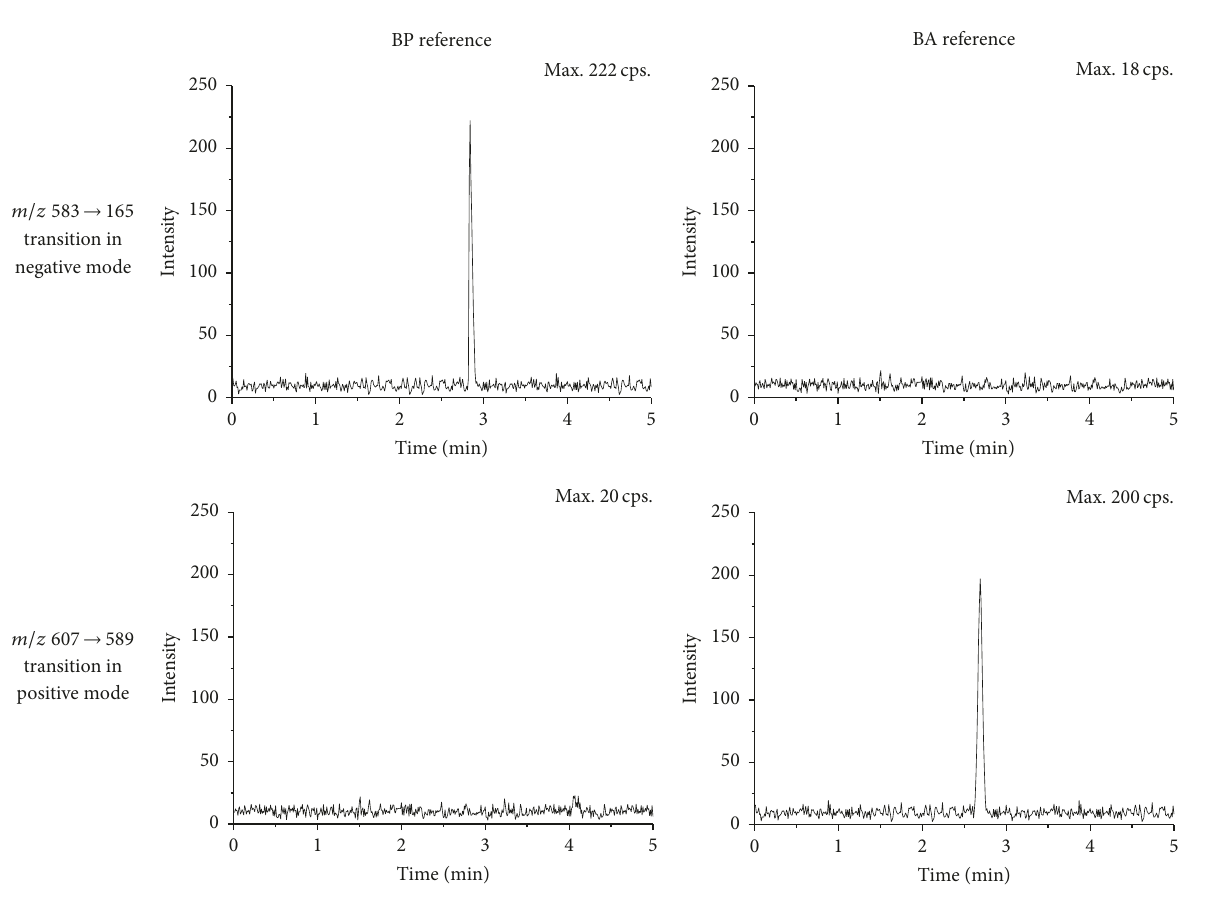
Figure 3: The specificity of m/z 583 → 165 in negative mode and m/z 607 → 589 positive mode on BP and BA